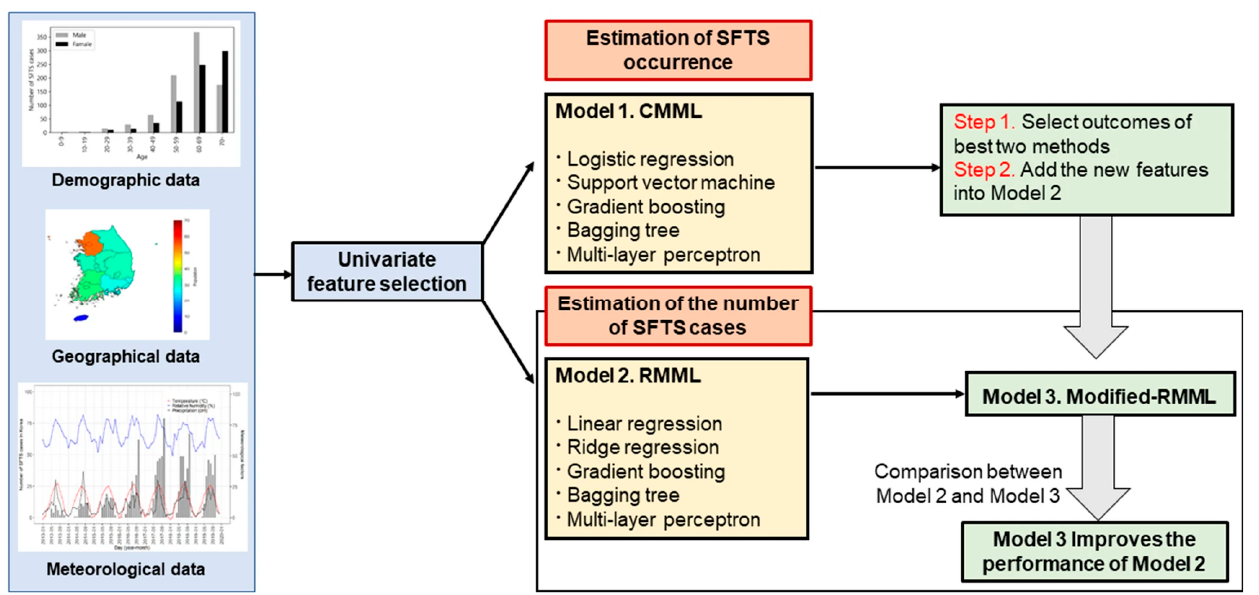
Figure 5. Schematic diagram for model predictions (Cho, G., S. Lee, and H. Lee 2021)[19].